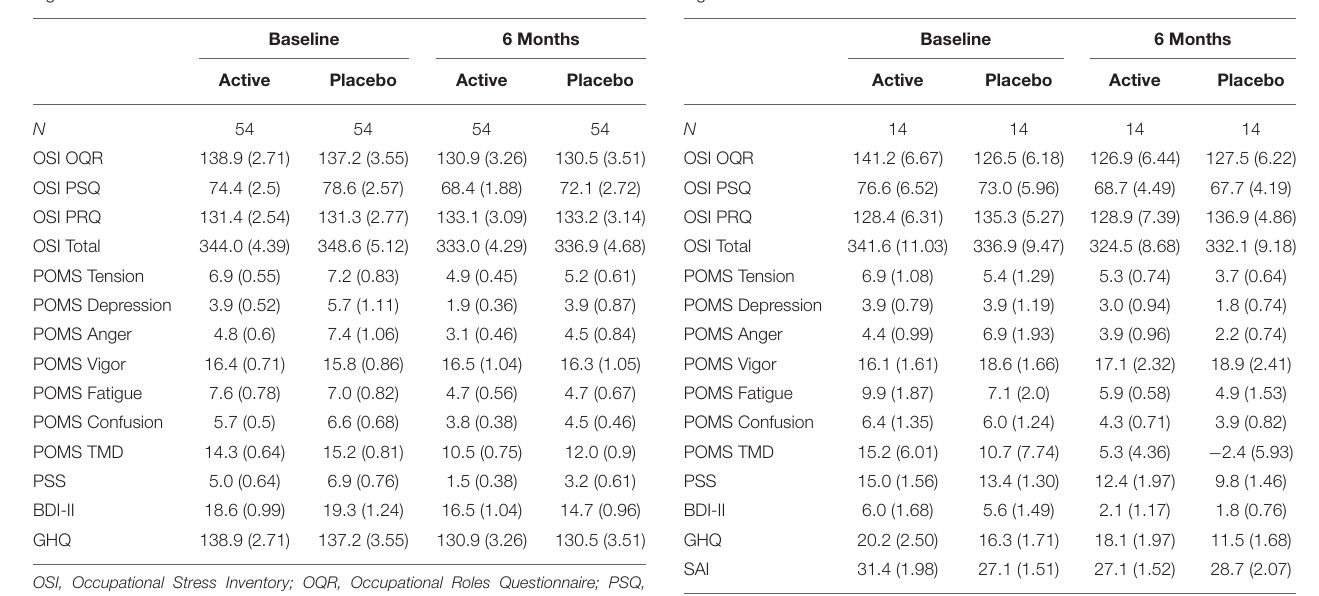
TABLE 2 | Means and standard error for psychometric indices between MRI participant groups at baseline and following 6-month supplementation of the high-B-vitamin